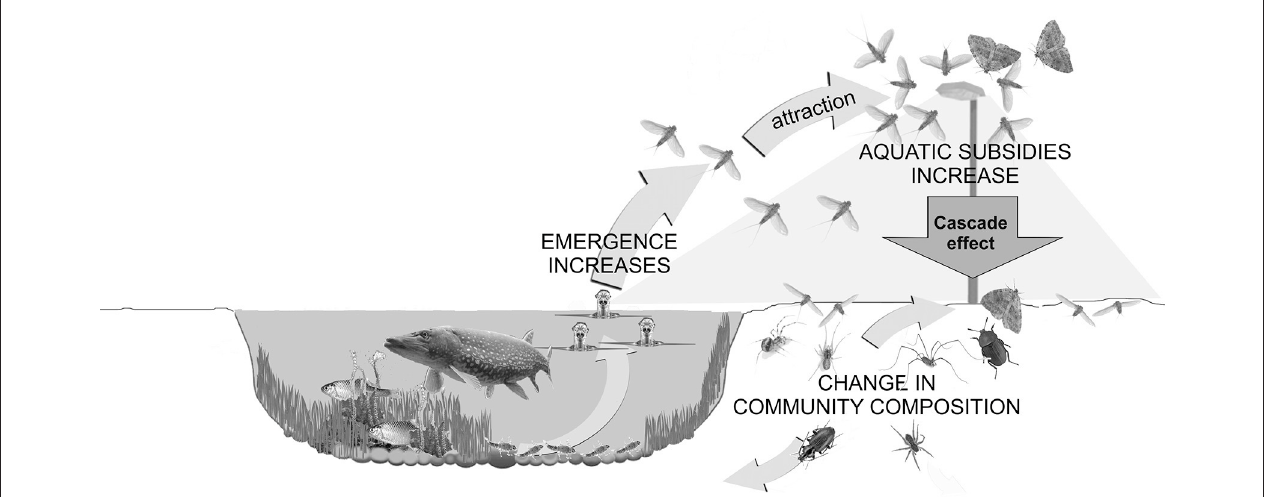
FIGURE 6 | Conceptual figure depicting how artificial light at night (ALAN) increases the flux of aquatic insects into the riparian area through an increase in emergence under lamps and increased attraction of aquatic insects to light. The community of riparian ground-dwelling predators and scavengers is altered in the lit area and some night-active riparian spiders extend their activity into the day. Both likely are the result of the large increase in input of freshwater-derived